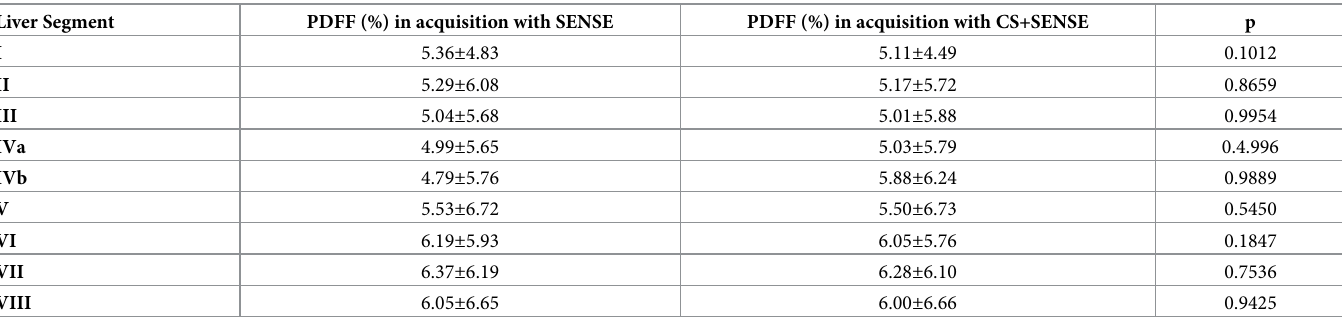
analyses were performed using Prism Version 7 ( GraphPad Software ). A two-tailed P-value below 0.05 was considered statistically significant.